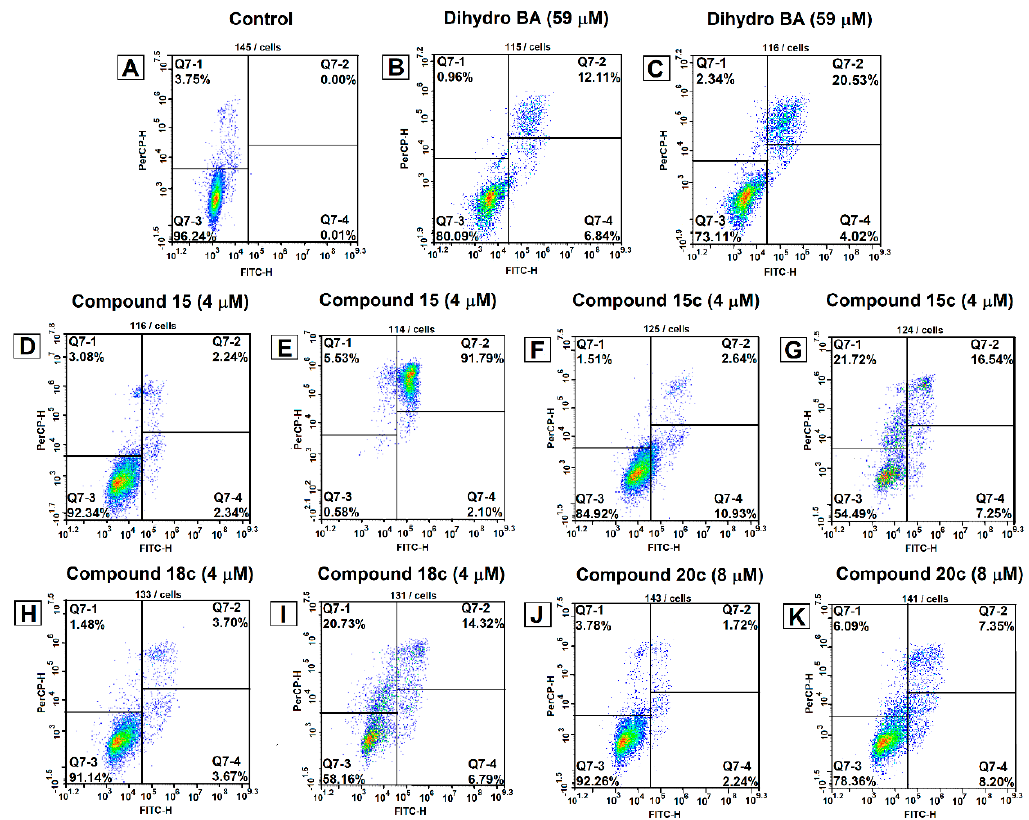
Figure 2. AnnexinV/7-AAD staining upon induction of apoptosis in Jurkat cells. Cells were treated with compounds at their IC 50 concentration for 24 and 48 h. Then, the cells were harvested, stained with Annexin V/7-AAD and analyzed by flow cytometry. The experiments were performed three times, and the results of the representative experiments are shown. The first cytogram represents an untreated cell sample ( A ); after incubation with dihydrobetulinic acid for 24 h ( B ) and for 48 h ( C ); after incubation with compound 15 for 24 h ( D ) and for 48 h ( E ); after incubation with compound 15c for 24 h ( F ) and for 48 h ( G ); after incubation with compound 18c for 24 h ( H ) and for 48 h ( I ); after incubation with compound 20c for 24 h ( J ) and for 48 h ( K ). Q7-1, necrotic cells; Q7-2, late apoptotic cells; Q7-3, living cells; Q7-4, early apoptotic cells.